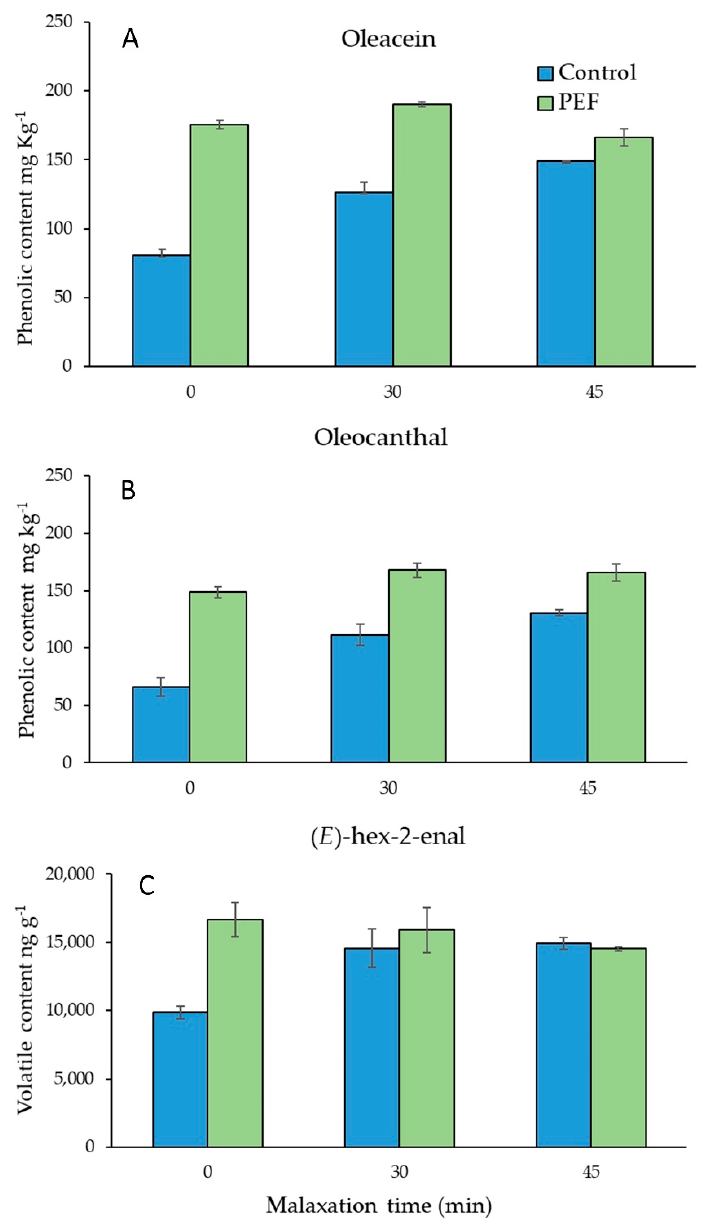
Figure 1. Content of oleacein, oleocanthal and ( E )-hex-2-enal in control and PEF oils obtained from ‘Manzanilla’ fruits using different malaxation times: 0, 30 and 45 min.